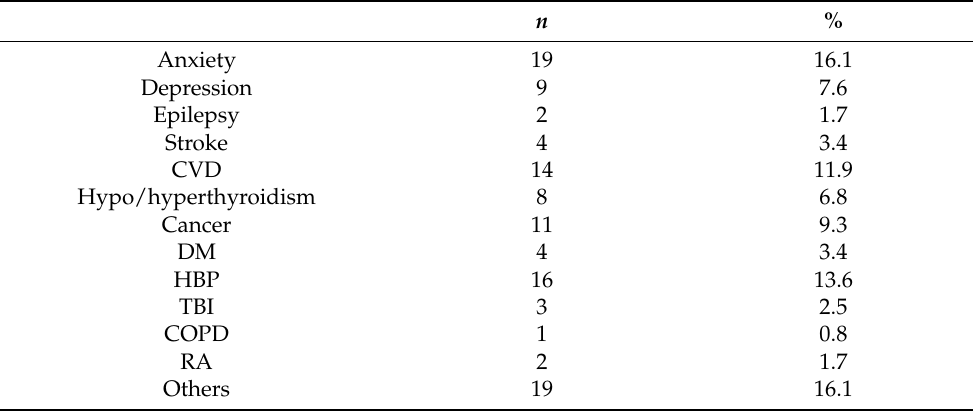
Table 2. Number (and %) of participants with medical history ( n = 118).